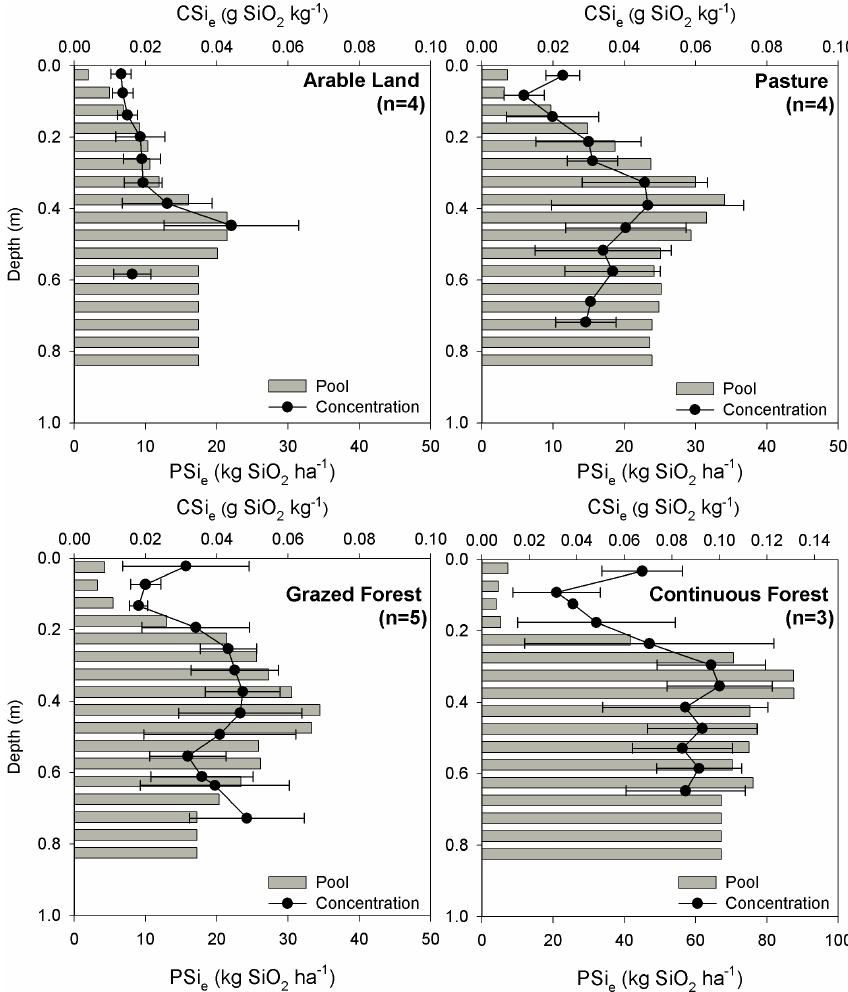
Fig. 3. Average distribution of easily (CaCl 2 ) soluble silica (CSi e , gSiO 2 kg − 1 dry soil) and total CSi e -pools (PSi e , kgSiO 2 ha − 1 ) by depth under various land uses in southern Swedish soils. N =number of profiles analysed under specific land use. Scale x-axis not